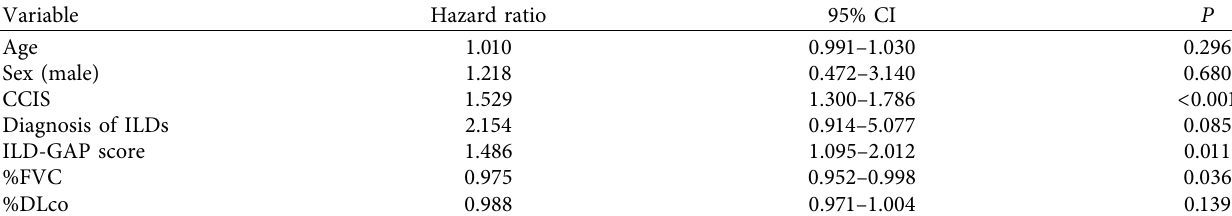
Table 4: Predictability for ILD-related events in the ILD-GAP and ILD-GAPC